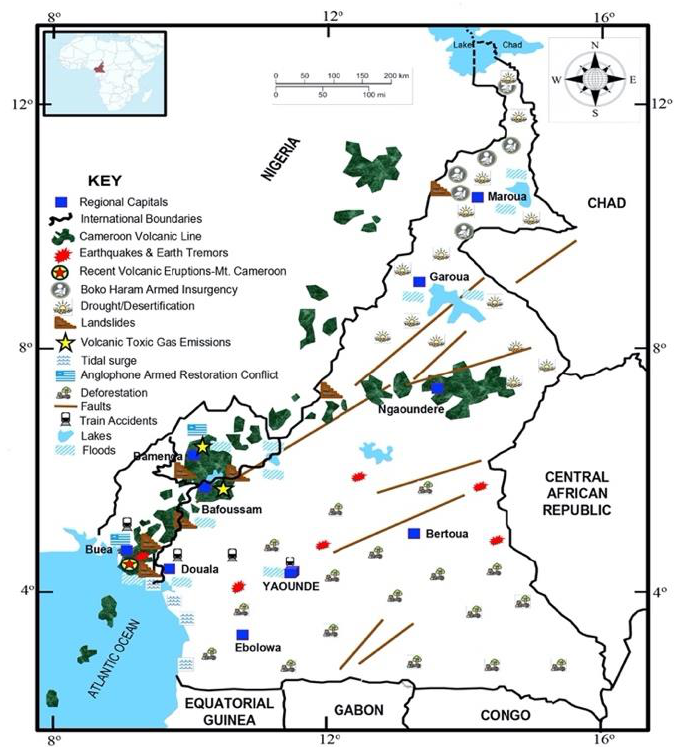
Figure 2. The main hazards in Cameron. Source: [19].